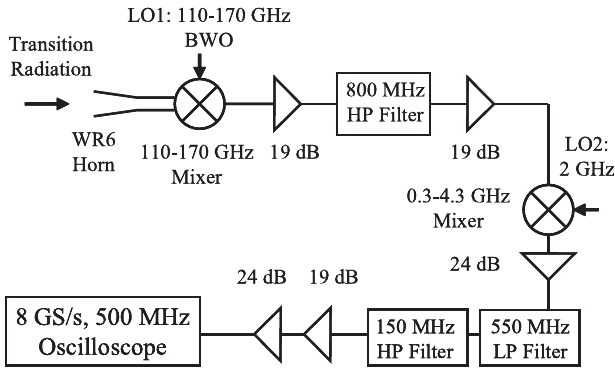
FIG. 2. Double heterodyne system schematic. Incoming radia- tion is mixed twice with local oscillators, filtered, amplified, and then read as FFT peaks on an oscilloscope.